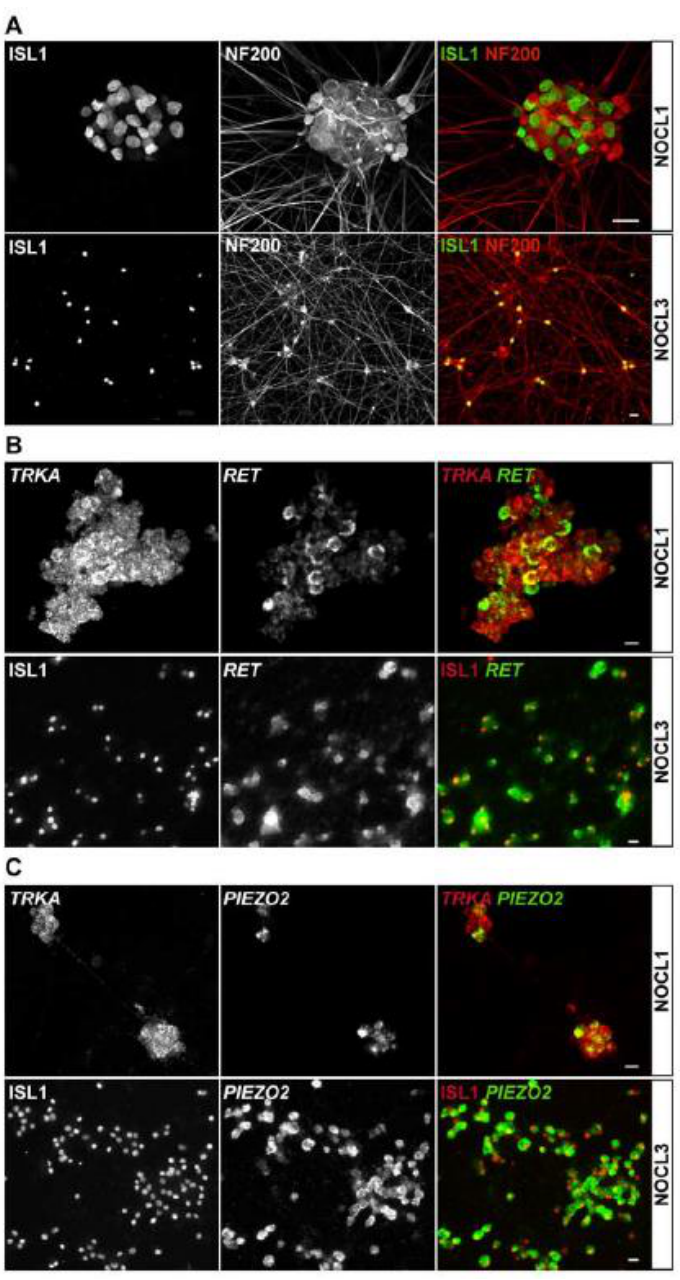
Figure 4. ( A ) Immunostaining of NOCL1 and NOCL3 cells detecting ISL1 protein ( left ), NF200 ( middle ), and the composite image ( right ). Note, the presence of neurofilament heavy 200 is essen- tially detected in all NOCL cells. ( B ) In situ hybridization of NOCL1 and NOCL3 cells with probes detecting TRKA (upper left and red) and RET (middle and green) as well as immunostaining for ISL1 (lower left and red) to show co-expression of TRKA and RET or ISL1 and RET. In NOCL1 cells 77.6 ± 0.5% of TRKA positive neurons co-expressed RET, compared to 97.4 ± 0.9% in NOCL3 cells ( n = 3). ( C ) In situ hybridization of NOCL1 and three cells with probes detecting TRKA (upper left and red) and PIEZO2 (middle and green) as well as immunostaining for ISL1 (lower left and red) to show co–expression of the respective markers: 64.2 ± 2.3% of TRKA positive NOCL1 neurons co-expressed PIEZO2, compared to 95.0 ± 2.4% in NOCL3 cells ( n = 3; mean ± SEM; scale bar 20 µ